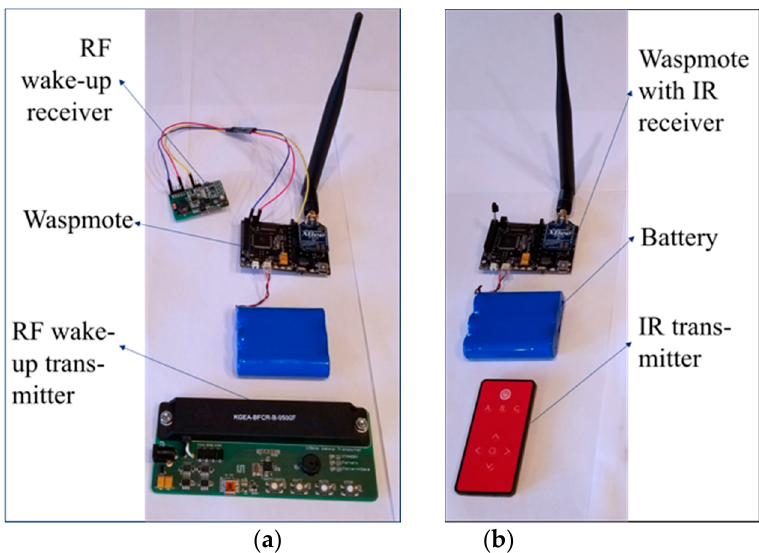
Figure 5. Design for the radio frequency (RF)-based active wake-up mechanism.